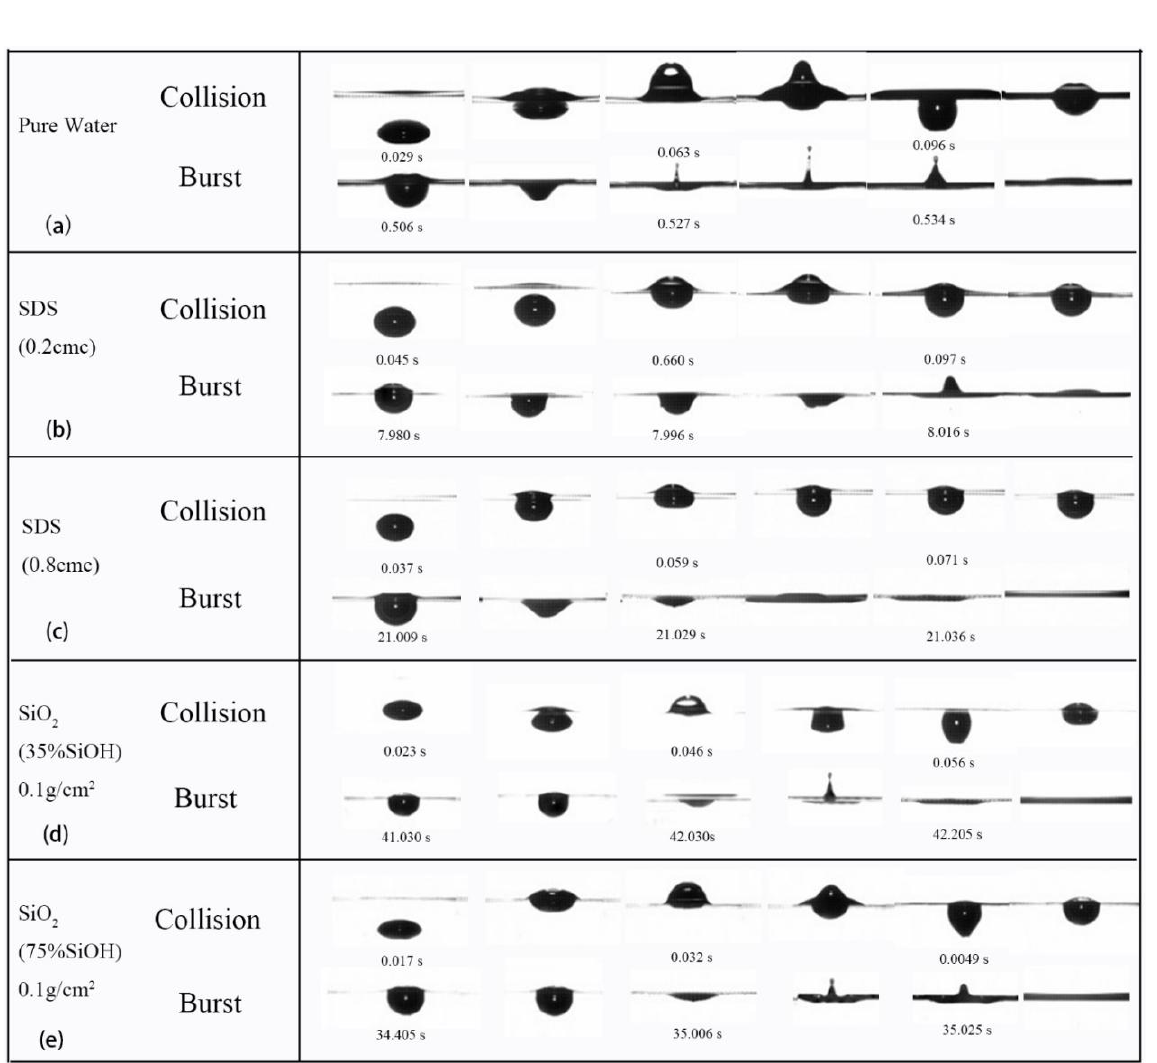
Figure 2. Bubble impact on different gas-liquid interface and its rupture process. ( a ) Ultrapure water condition only; ( b )the SDS solution with a concentration of 0.2 cmc used in the aqueous phase; ( c ) the SDS solution with a concentration of 0.8 cmc used in the aqueous phase; ( d ) the gas-liquid interface laden with SiO 2 nanoparticles of 35% SiOH; ( e ) the gas-liquid interface laden with SiO 2 nanoparticles of 75% SiOH.